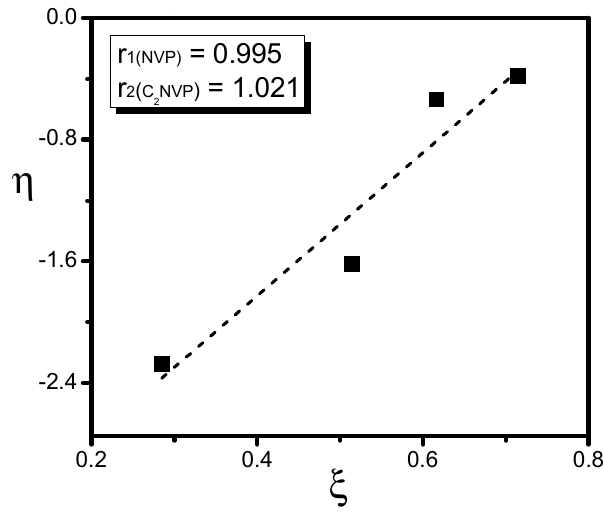
Figure 4. Kelen–Tüdos plot of RAFT copolymerization of C 2 NVP and NVP.